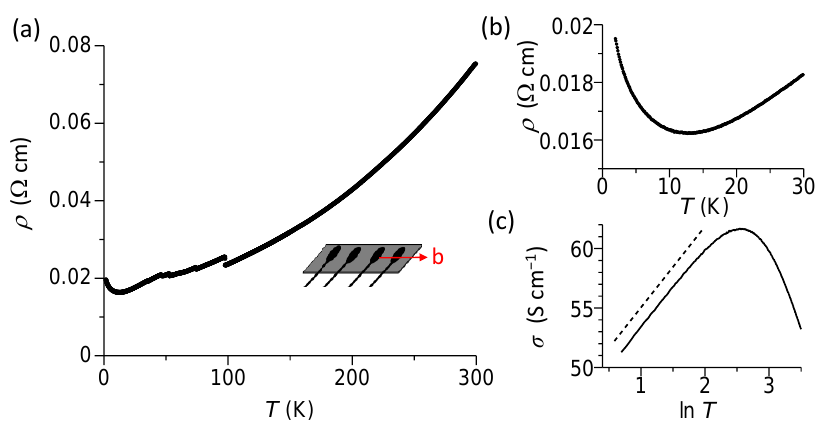
Figure 2. ( a ) The temperature ( T ) dependence of intralayer ( b -axis) resistivity ( ρ ) of β ” -BO3 (sample #1). ( b ) Intralayer resistivity in the low temperature region. ( c ) Intralayer conductivity as a function of ln T . The broken line represents the relationship of σ ∝ ln T .